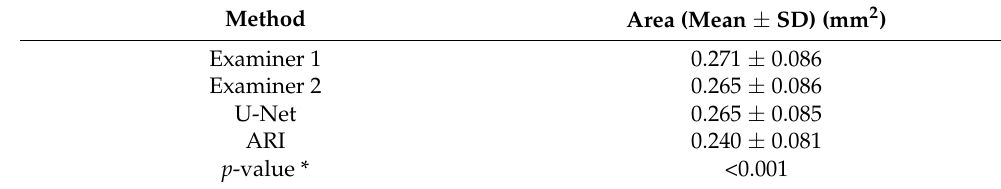
Table 1. The FAZ area obtained by each extraction method and results of the Friedman test.